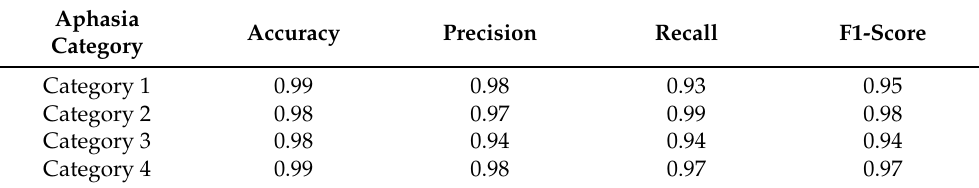
Table 13. Aphasia category-wise classification performance evaluation metrics of DNN model when 10 s audio chunks are